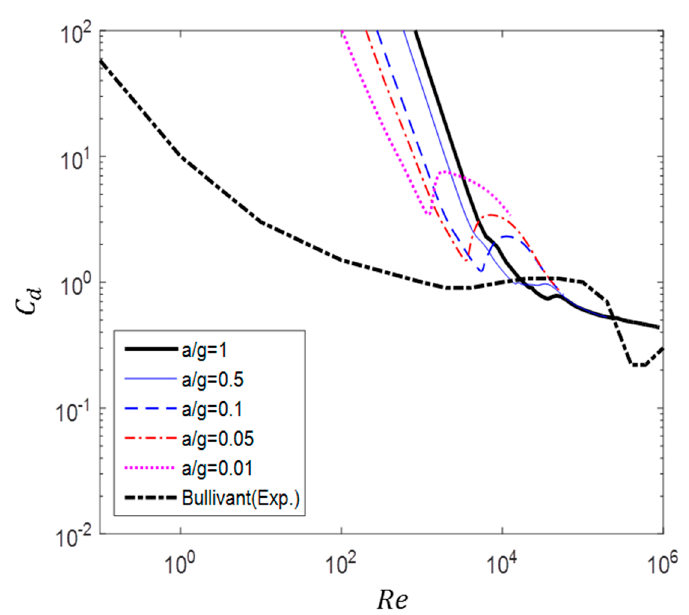
Figure 9. Comparison of drag coe ffi cient C d between non-accelerated flow (Bullivant [20]) and accelerated flow ( Re 0 = 40).